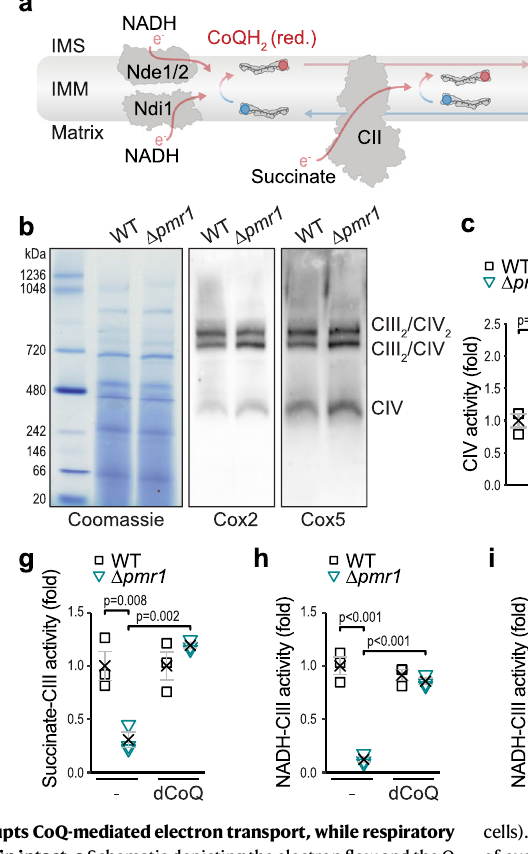
cells).Cellsweregrownonglucosefor24h.CIVactivityassessedthroughoxidation of exogenous reduced cytochrome c (cyt c ) ( c , e ), NADH/succinate-independent CIII activity with exogenous decylubiquinol and oxidized cyt c ( d , f ), succinate- driven CIII activity with and without supplementation of decylubiquinone (dCoQ) ( g ) and NADH-driven CIII activity with and without supplementation of dCoQ ( h , i ) are shown. Means±SEM, n =3. j Spectrophotometric analysis of NADH-driven